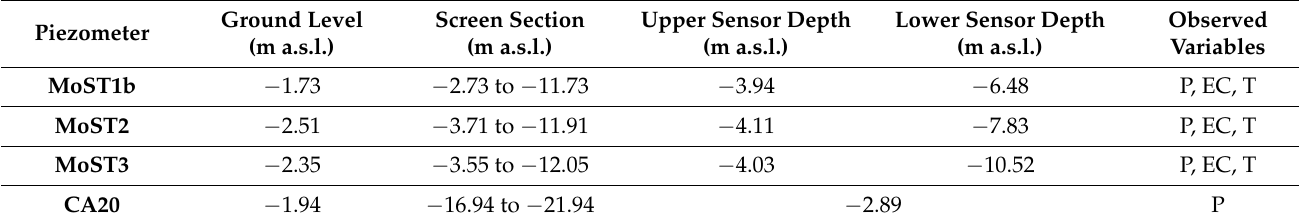
Table 1. Summary of the characteristic of the monitoring piezometers at the Venice coastal aquifer site.